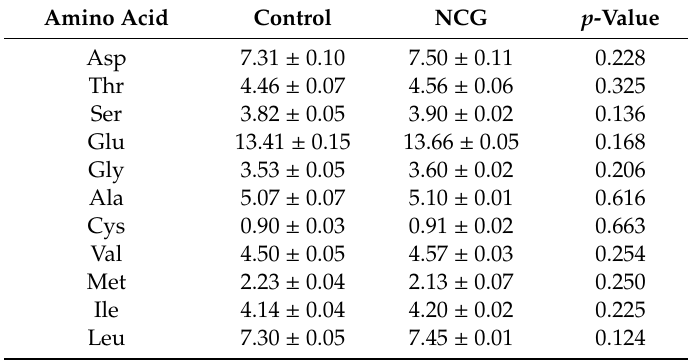
Table 3. E ff ect of N -carbamylglutamate on hydrolytic amino acid concentration in the longissimus dorsi muscle of Ningxiang pigs, g / 100